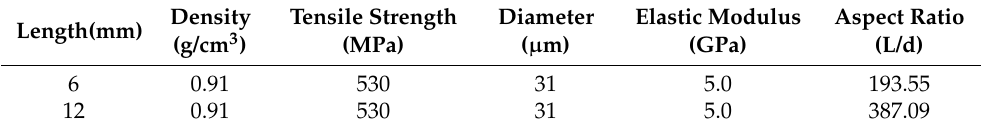
Table 2. Properties of the polypropylene